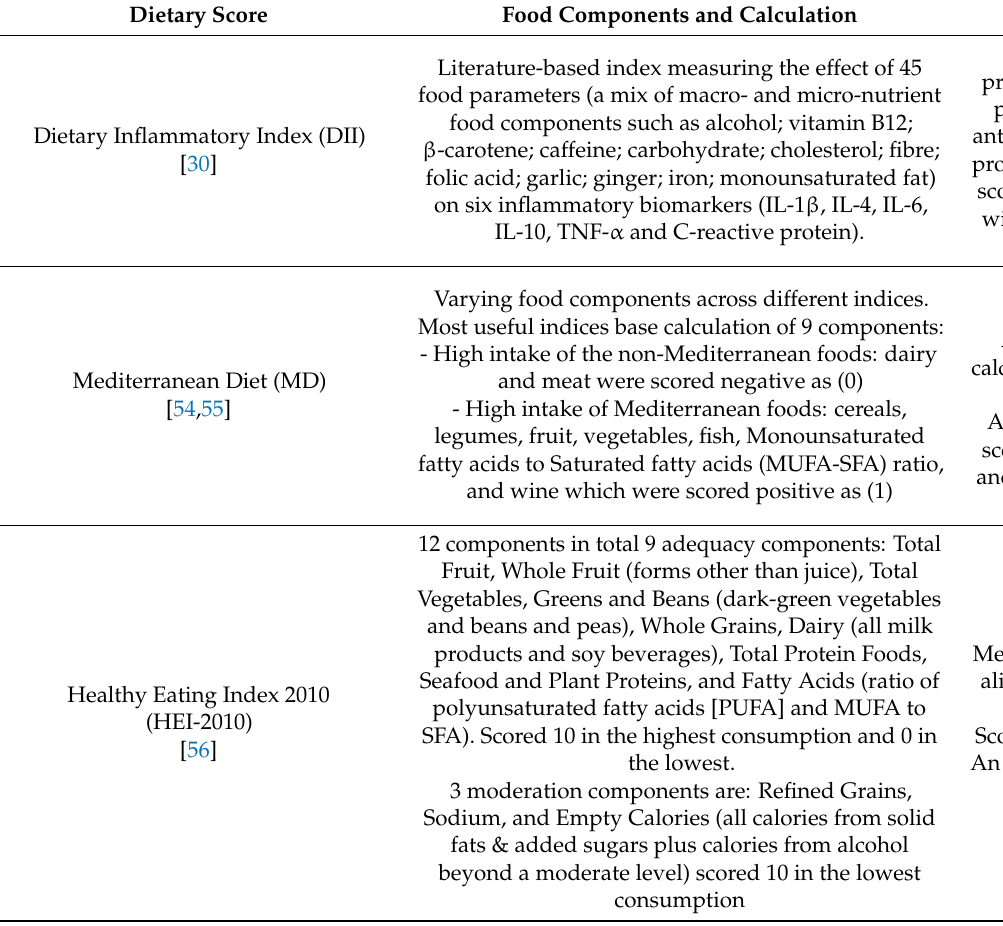
Table 1. Summary of Dietary Metric